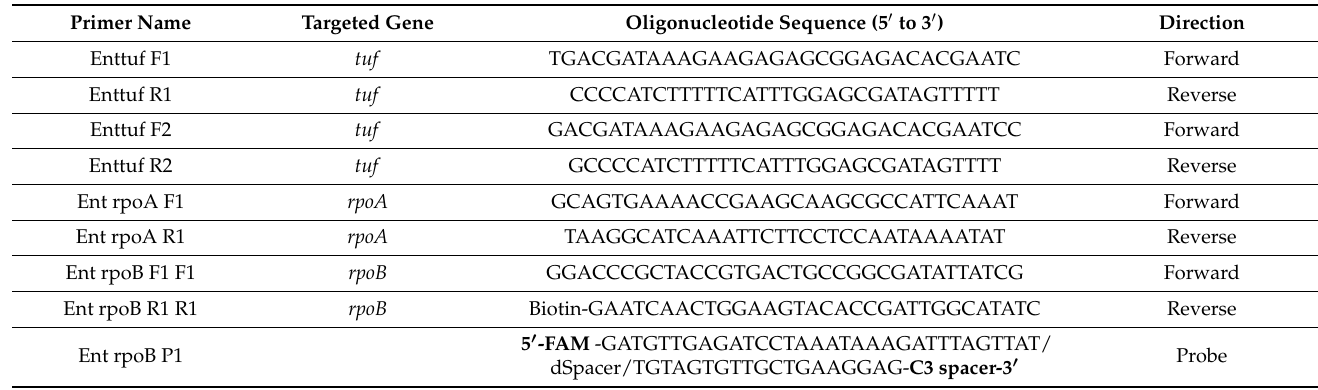
Table 1. Primers targeting the genes rpoB, rpoA, and tuf , and probe used for recombinase polymerase amplification (RPA) coupled with lateral flow